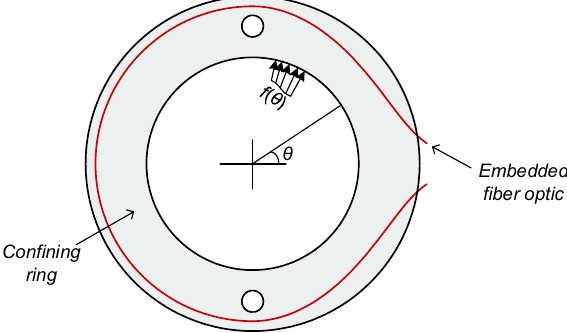
Figure 2. Illustration of a confining ring involved in a direct simple shear